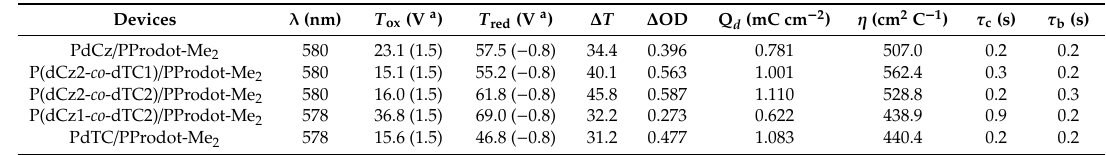
Table 5. Optical and electrochemical properties investigated at the selected applied wavelength for the